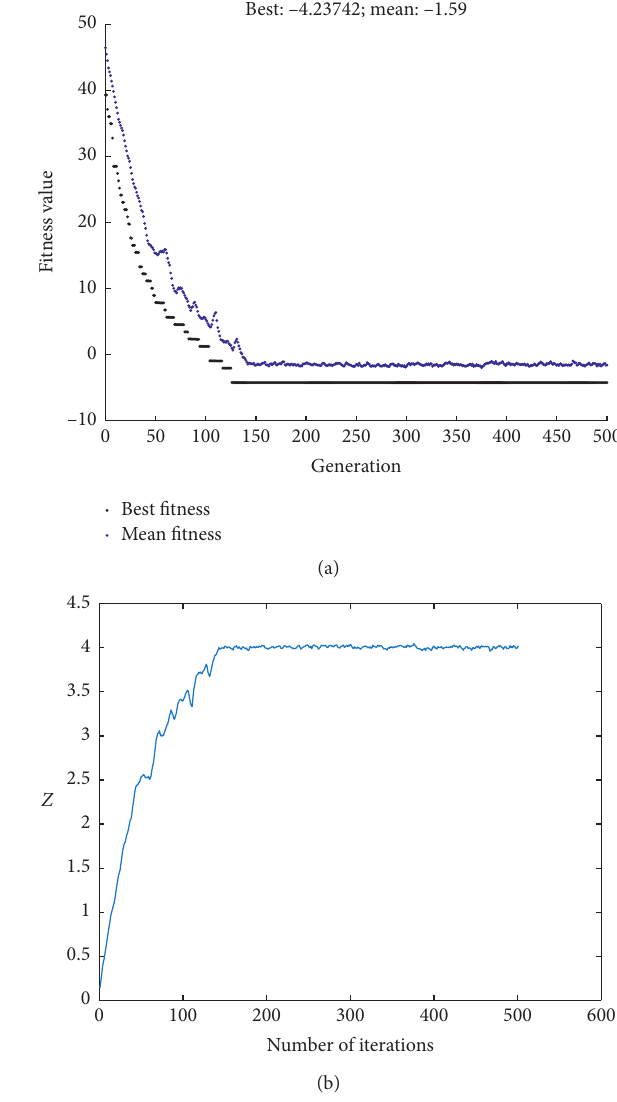
Figure 8: Genetic algorithm evolution curve. (a) Number of it- erations. (b) Fitness